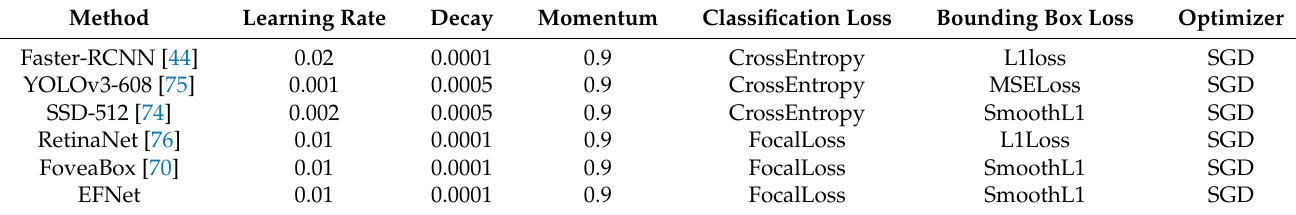
Table 2. The hyper-parameter setting of the comparative